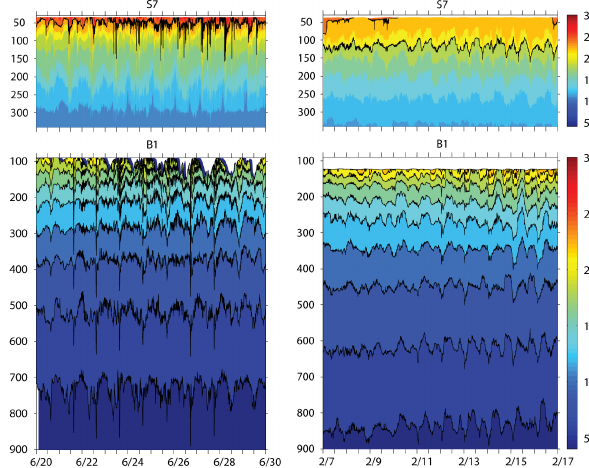
Fig. 8. Temperature contours for mooring S7 (top) and B1 (bottom) for a) 20–30 June 2005 and (b) 7–17 February 2006 showing wave occurrences vs. stratification. The black line at S7 during June highlights the 24 ◦ C isotherm. The other black line at S7 in February tracks the 20 ◦ C